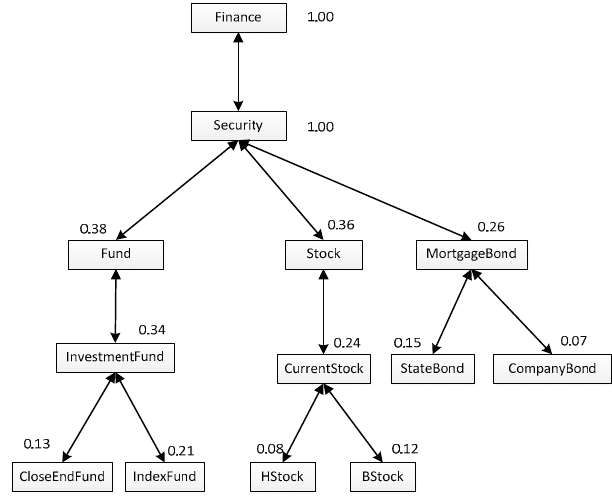
Figure 3. The user personalization model of u b .